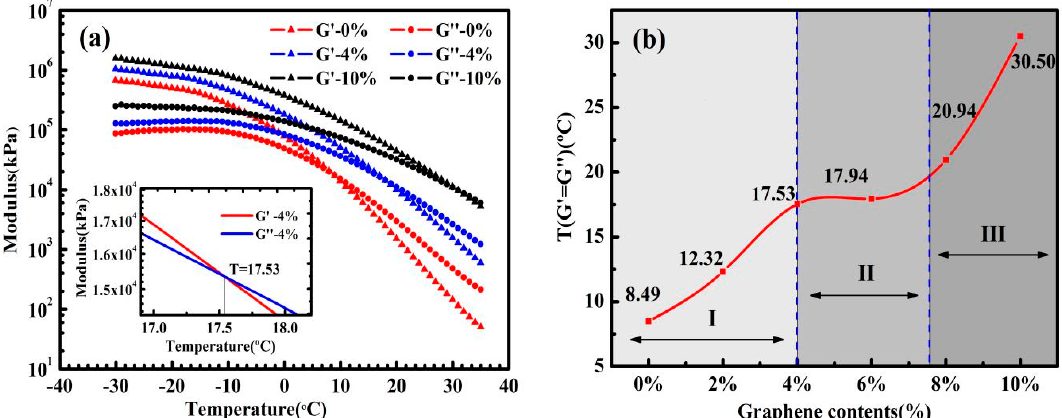
Figure 8. ( a ) Temperature sweep results of control asphalt and GMAs (modulus versus temperature) at − 30–35 °C, the content of graphene is 0%, 4%, and 10%. ( b ) The temperature of G’ = G’’ of control asphalt and GMAs.